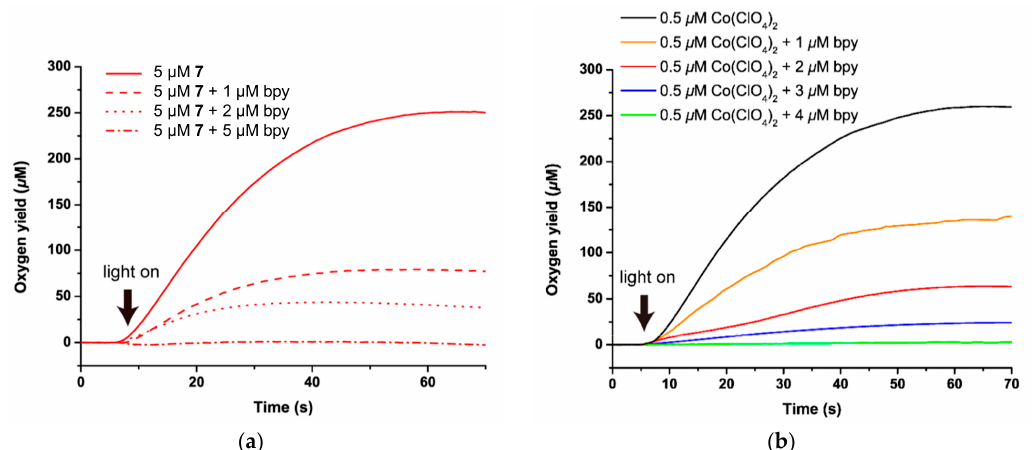
Figure 4. Accumulations of the oxygen in the course of water oxidation catalyzed by complex 7 ( a ) or Co(ClO 4 ) 2 ( b ), in the presence of various amounts of bipyridine (bpy) chelating agent. Adapted with permission from [52], American Chemical Society, 2016.